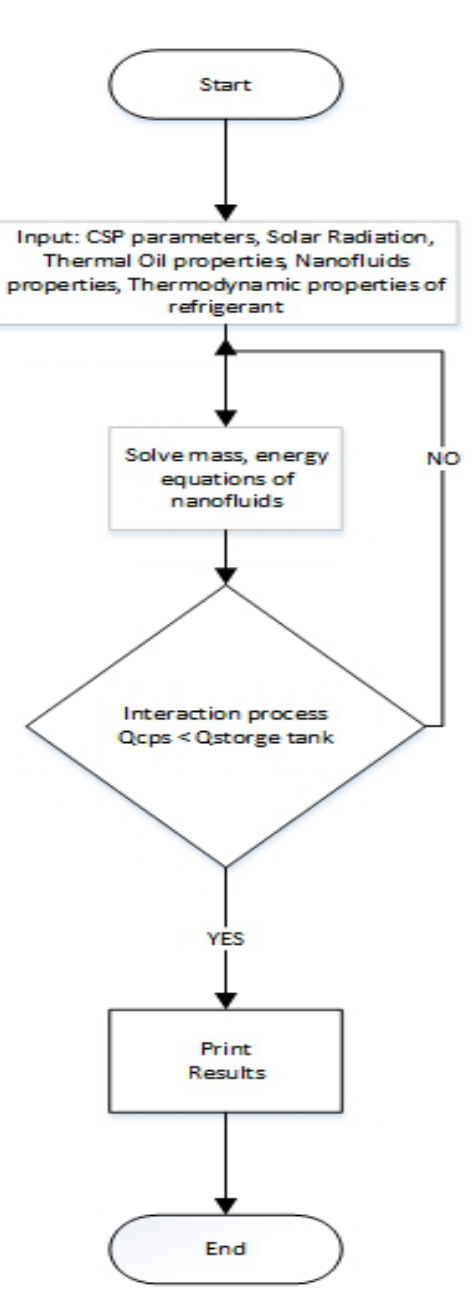
Figure 3. Logical diagram for numerical model.